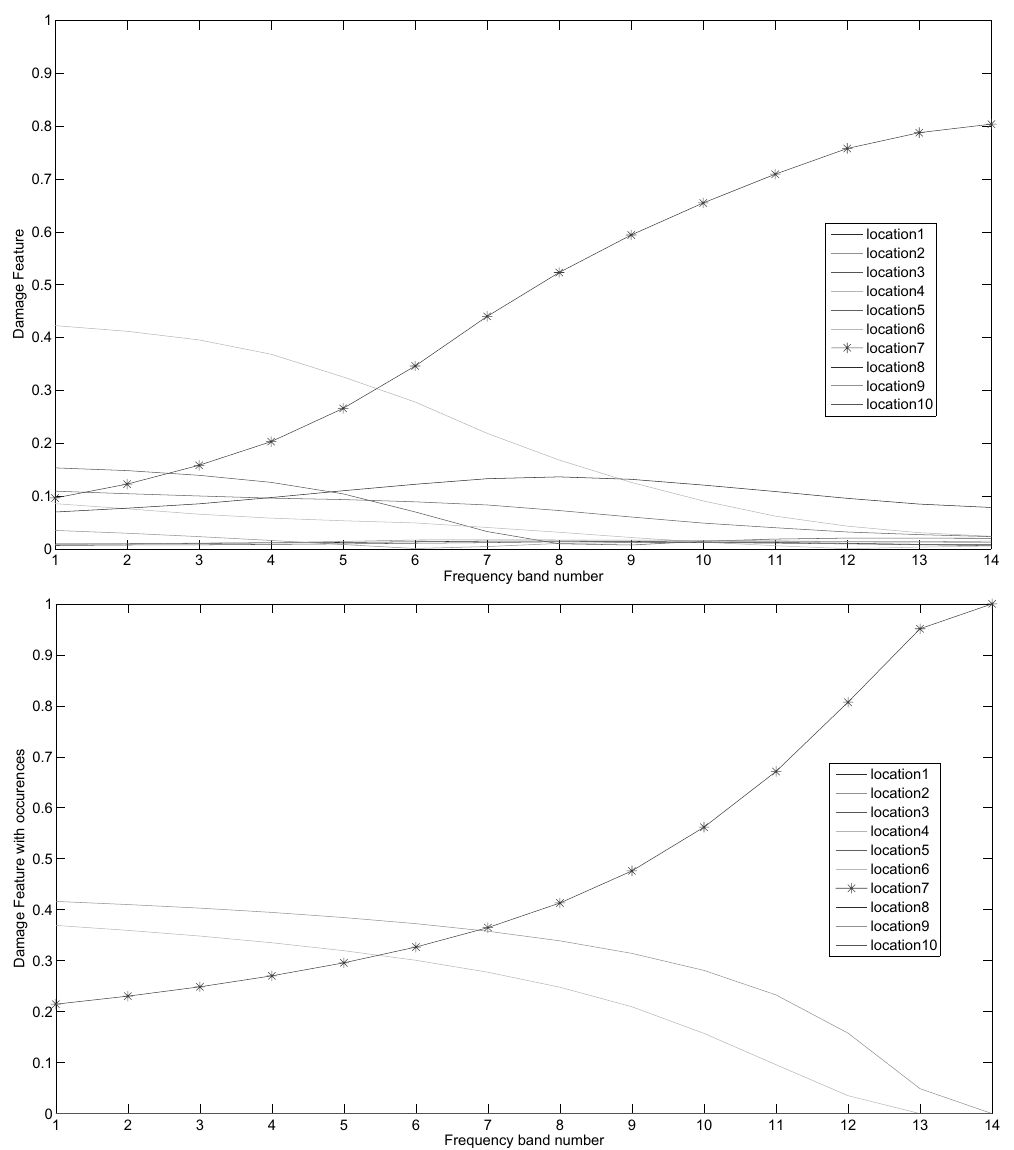
Fig. 41. Relative damage feature without (top) and with occurrences (bottom) for damaged structure and changing loading conditions for different frequency bands. case we only used the information of the frequency bands, 10–15 Hz and 83–86 Hz, respectively around the first and second resonance frequency of the structure, and discarded all other information. At first glance the results are easier to analyze compared to those obtained using the arbitrary frequency band of 10–100 Hz or 10–30 Hz, as was shown in Figs 30 and